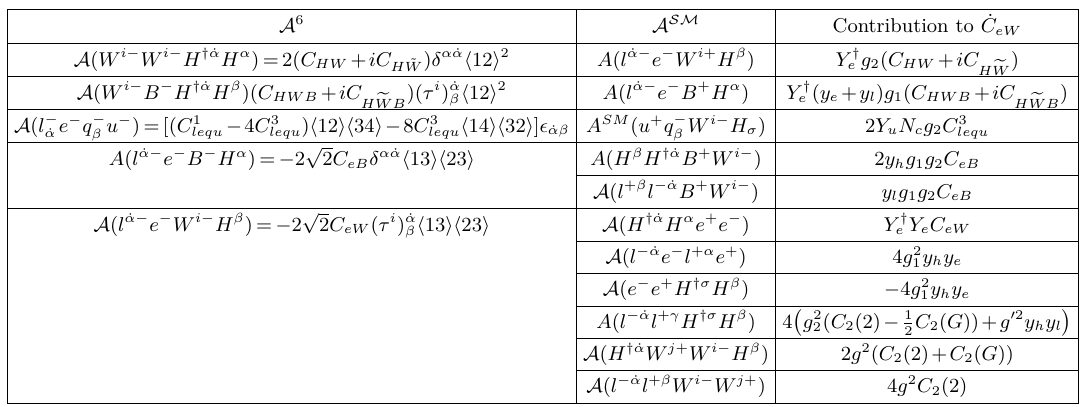
Table 1 . Contributions to the running of O eW from different unitary cuts. A 6 are on-shell ampli- tudes from dimension 6 operators and A SM are SM amplitudes. Here t j t i t j = ( C 2 (2) − 1